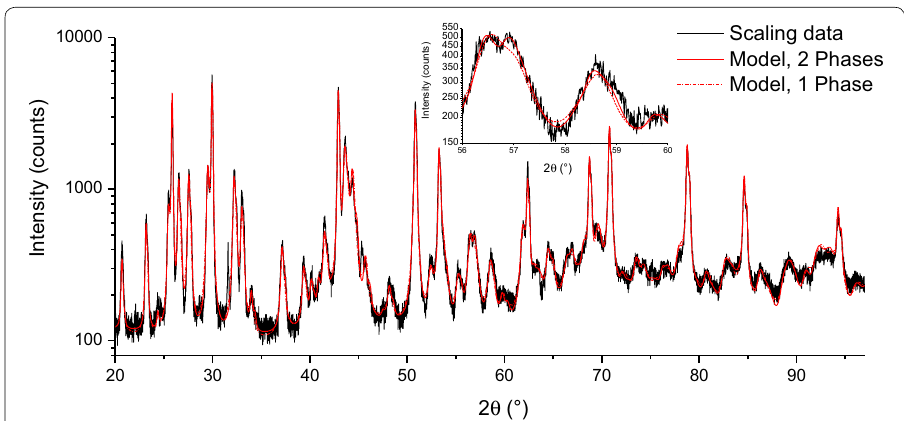
Fig. 4 XRPD data ( black line ) and Rietveld models of the scaling sample. The full red line represents the model containing two (Ba,Sr)SO 4 phases, the dashed line represents the model containing a single (Ba,Sr)SO 4 phase. The inset highlights the improvement of the model from single- to two phases. The double peaks are better reproduced using two